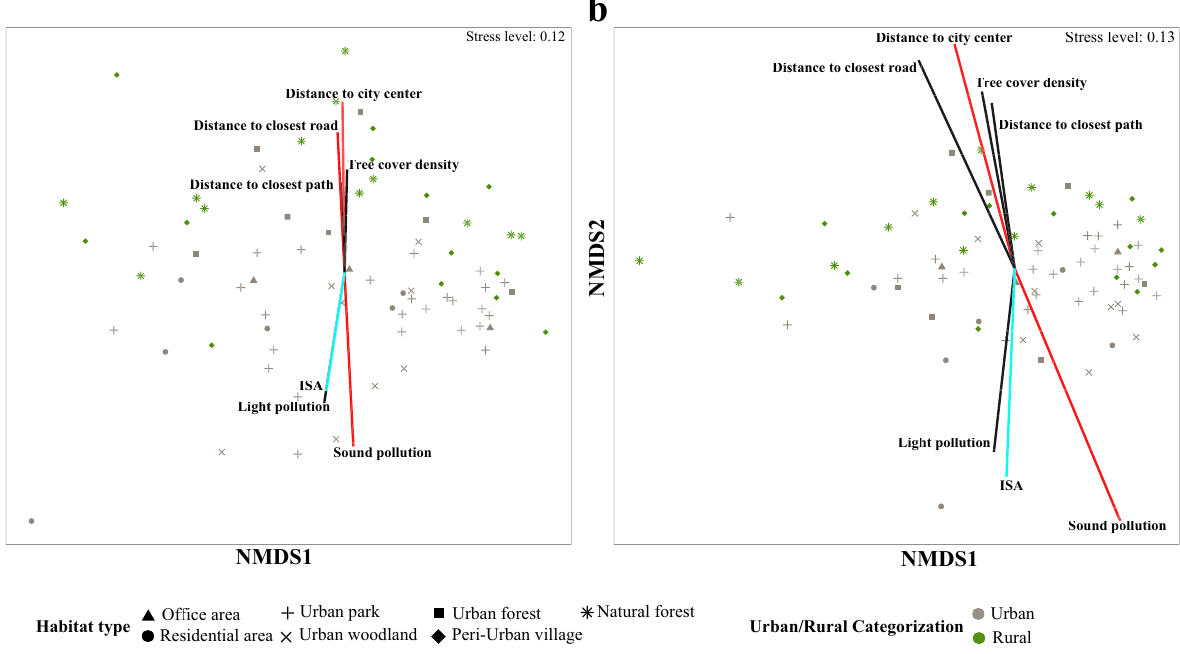
Figure 5. nMDS plots of microbial dissimilarities based on ( a ) Bray–Curtis and ( b ) Weighted UniFrac distances among samples collected from different sampling sites located in urban and rural areas. The lengths of vectors are proportional to their predictive strength, determined based on Envfit . All variables that were significant based on at least one test are represented (The significance was determined based on being included in the best BIOENV model or at p-values ≤ 0.05 in Envfit or partial Mantel test). The parameters considered significant in all tests are coloured in red. The figure was generated in R version 4.0.0 68 .